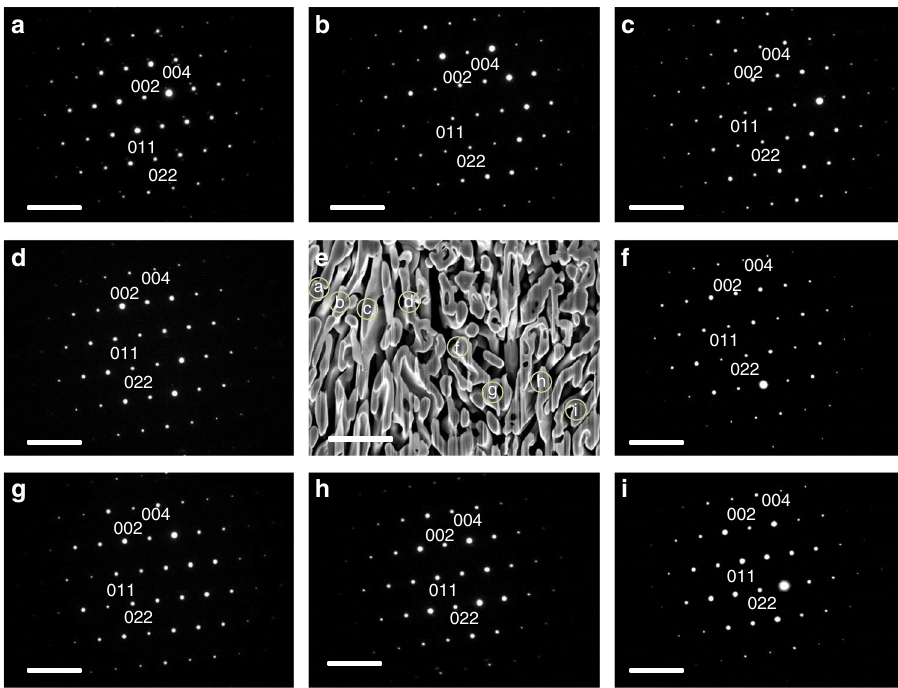
Fig. 2 Cross-sectional view and selected area electron diffraction (SAED). The ( a – d ) and ( f – i ) present the SAED pattern at different locations on the skeleton of the P-SC anatase Ti 38 O 75 crystal. The e presents the cross-sectional view of the P-SC anatase Ti 38 O 75 crystal while the locations for SAED pattern are labeled. The porous single-crystalline (P-SC) anatase Ti 38 O 75 crystal is grown along with the a -axis of KTP substrate. The scale bar is 5 1/nm in ( a – d ) and ( f – i ). The scale bar is 1 μ m in ( e